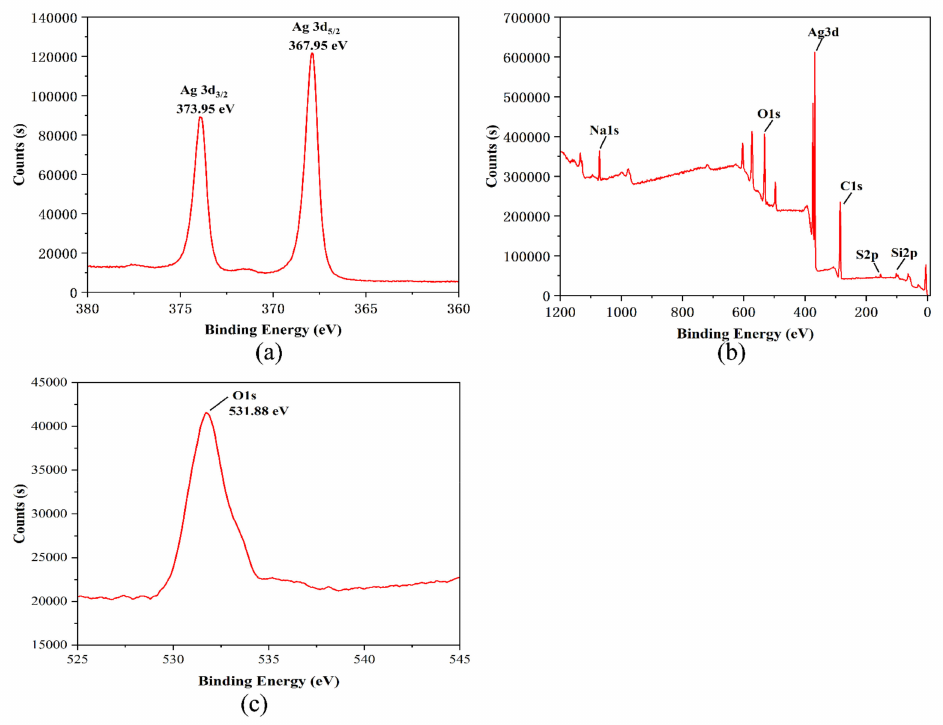
Figure 6. ( a ) XPS analysis of silver elements in R-AgNPs, ( b ) XPS analysis of all elements in R-AgNPs, ( c ) XPS analysis of oxygen in R-AgNPs. Table 1. The elements of R-AgNPs. Element Binding Energy (eV) Atomic